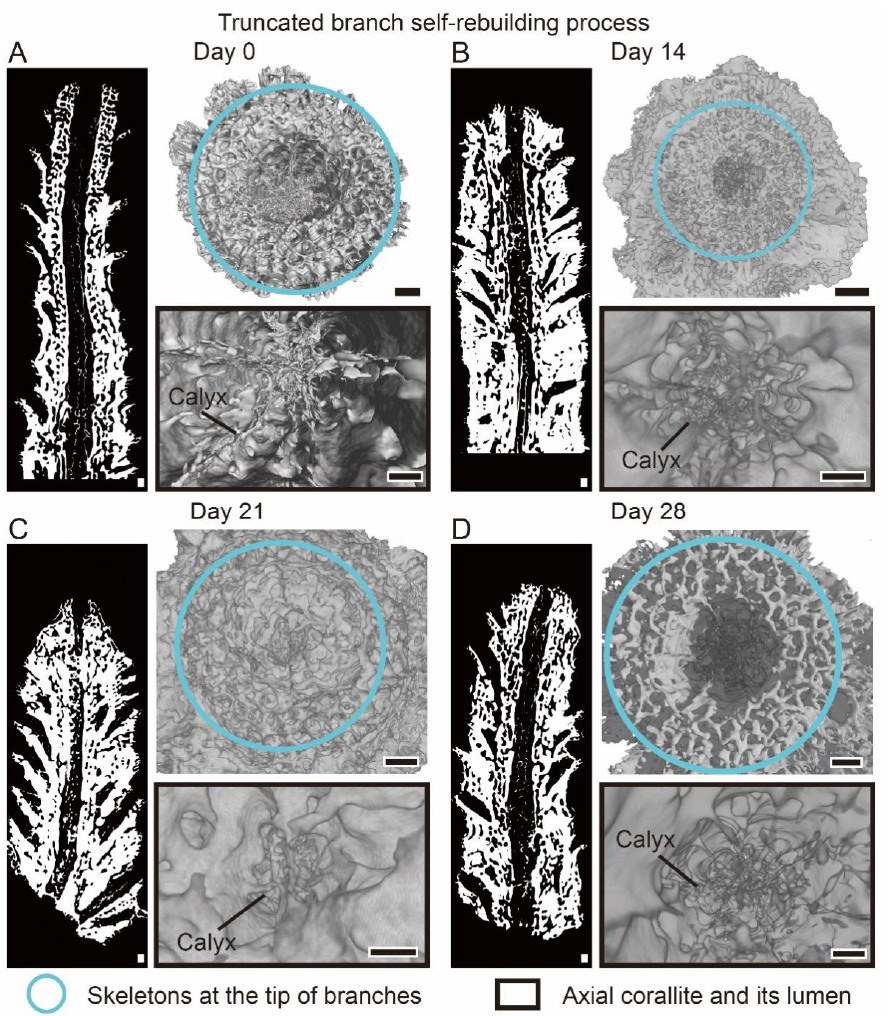
Figure 2. Structure of the axial corallite during the process of truncated branch self-rebuilding in A. muricata . ( A – D ). The rebuilding process of the truncated branch. Scale: 0.5 mm.